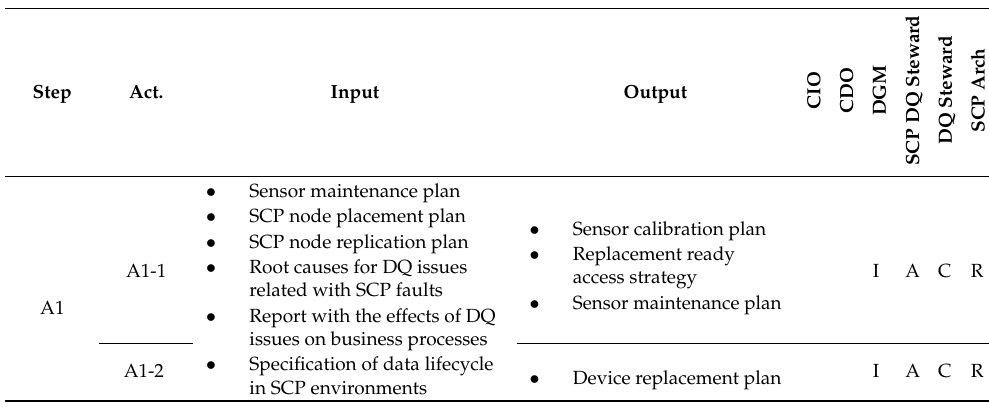
Table 8. Inputs, outputs and RACIQ matrix for the Act phase. (R—Responsible (works